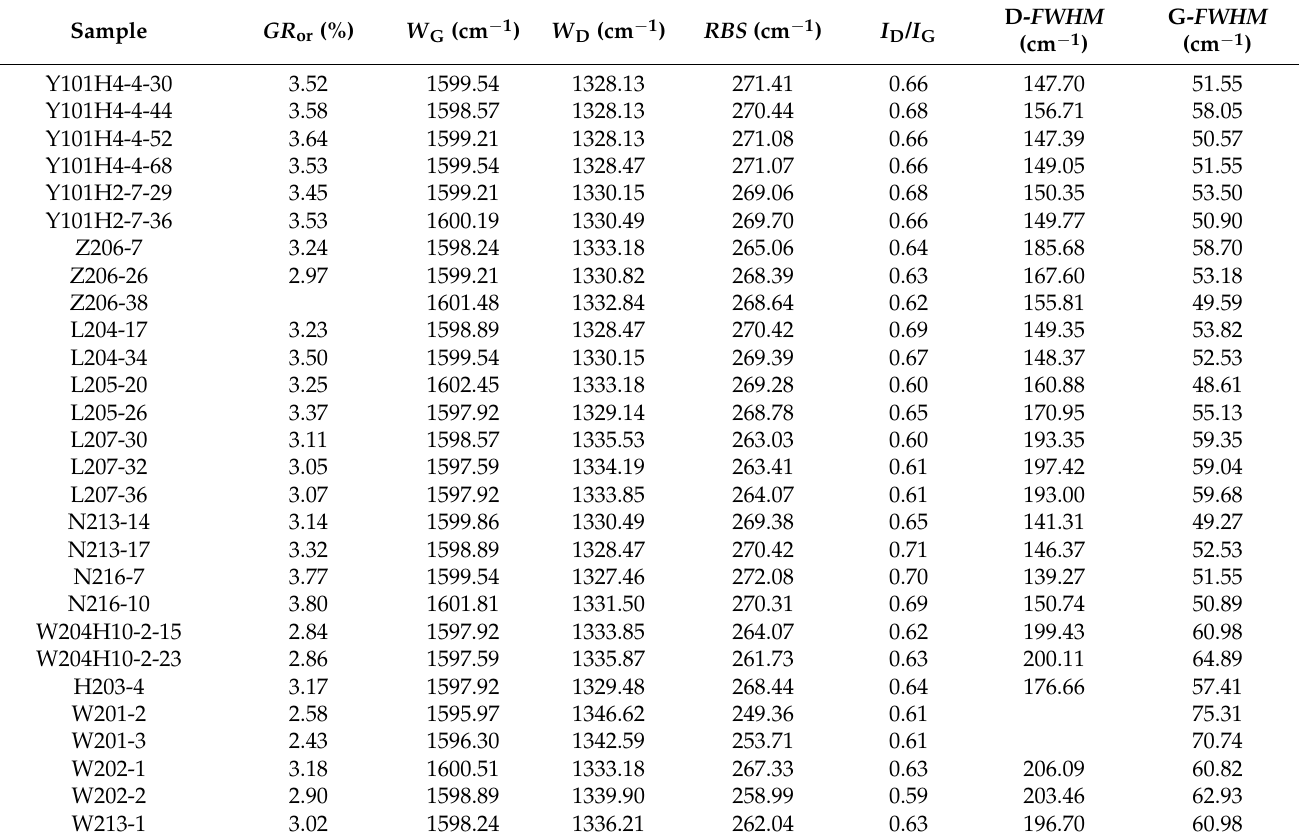
Table 2. Raman spectroscopic parameters of kerogen in the Wufeng–Longmaxi Formations from southern Sichuan